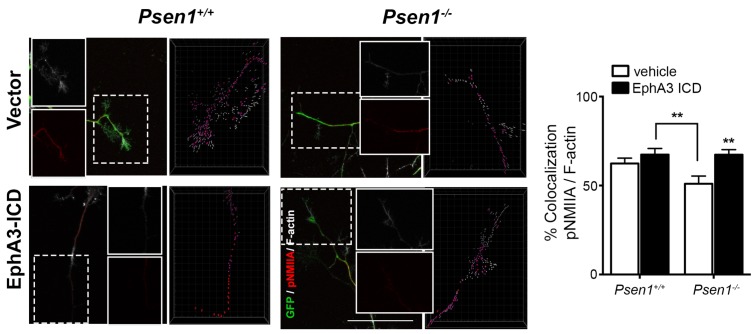
Reduced pNMIIA/F-actin colocalization in growth cones of Psen1-/- neurons.Colocalization of pNMIIA and F-actin at growth cones of neurons from Psen1+/+ and Psen1-/- embryos. EphA3 ICD overexpression increases the pNMIIA spots that colocalize with F-actin at growth cones. Statistics was tested by two-way ANOVA followed by Bonferroni post hoc test. **p<0.01, as indicated and EphA3 ICD- vs vector-transfected Psen1-/- neurons. Data are mean ± SEM of 3 experiments (n = 26–33 neurons/group). Scale bar, 50 μm.